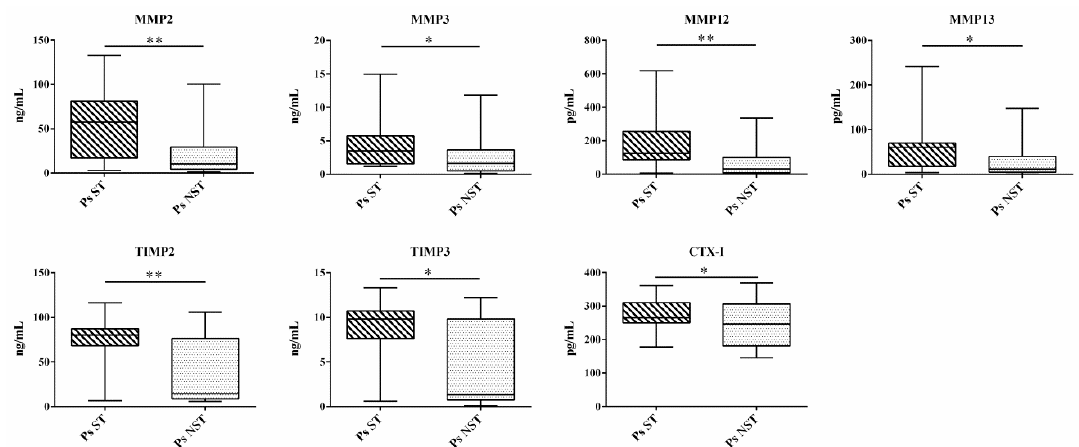
Figure 2. Changes in the serum profile of osteoimmunological markers in Ps ST group (hashed box) and Ps NST group (grey box). The box and whiskers plot identifies, respectively, the value of the median (intermediate line), the 25th and 75th percentile (box), and the minimum and maximum value (whiskers). Asterisks indicate significant intergroup differences (* p < 0.05, ** p < 0.01). CTx-I: C-terminal cross-linked telopetide of type I collagen, MMP: Matrix metalloproteinases, NST: not systemically treated, Ps: Psoriasis, PsA: Psoriatic arthritis, ST: systemically treated, TIMP: Tissue inhibitor of metalloproteinases.